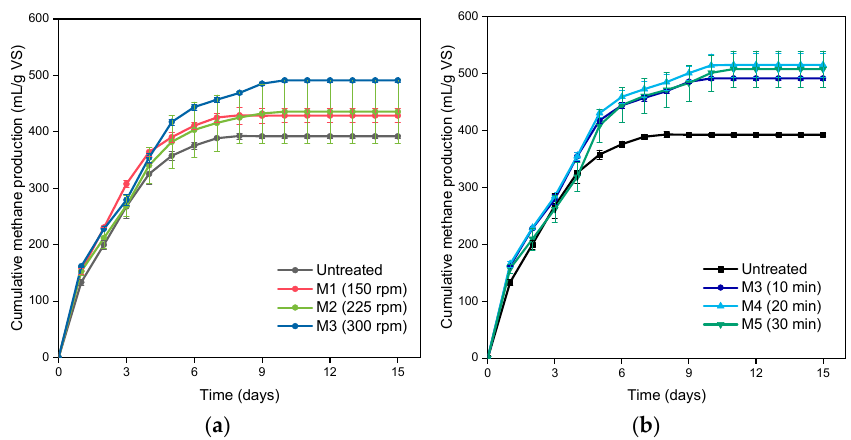
Figure 2. Cumulative methane productions from the food waste based on ( a ) milling speed and ( b ) milling time. The error bars indicate standard deviation.